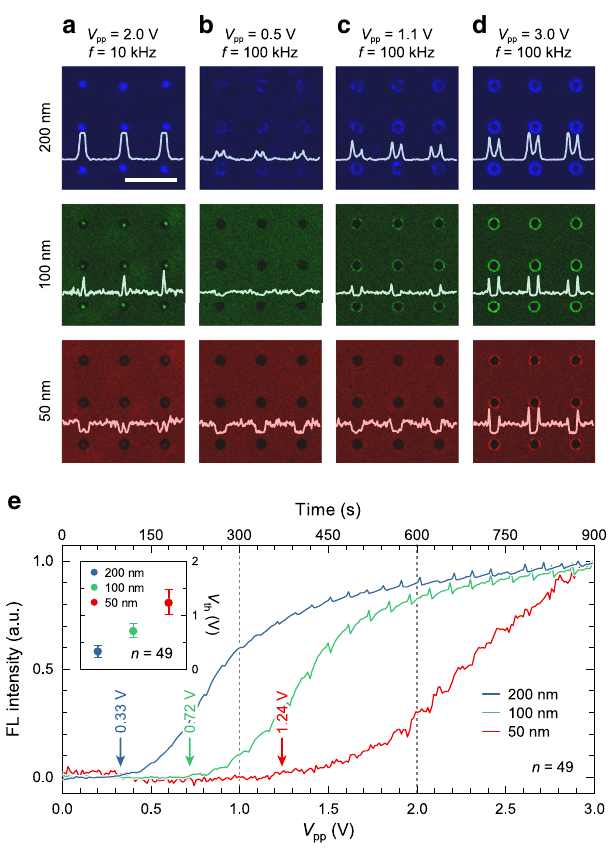
Fig. 4 Size-selective trapping of PS NPs at various AC voltages. a – d Experimental micrographs of captured PS NPs with diameters of 200 nm ( fi rst row; blue), 100 nm (second row; green), and 50 nm (third row; red) under V pp = 2 V at f = 10 kHz ( a ), V pp = 0.5 V ( b ), 1.1 V ( c ), and 3 V ( d ) at f = 100 kHz. Scale bar, 50 μ m. e Averaged FL intensities of captured PS NPs on 49 unit cells as a result of increasing V pp ( f = 100 kHz) from 0 to 3 V by 0.1 V for every 30 s; averaged trapping thresholds of 0.33, 0.72, and 1.24 V for 200, 100, and 50 nm, respectively